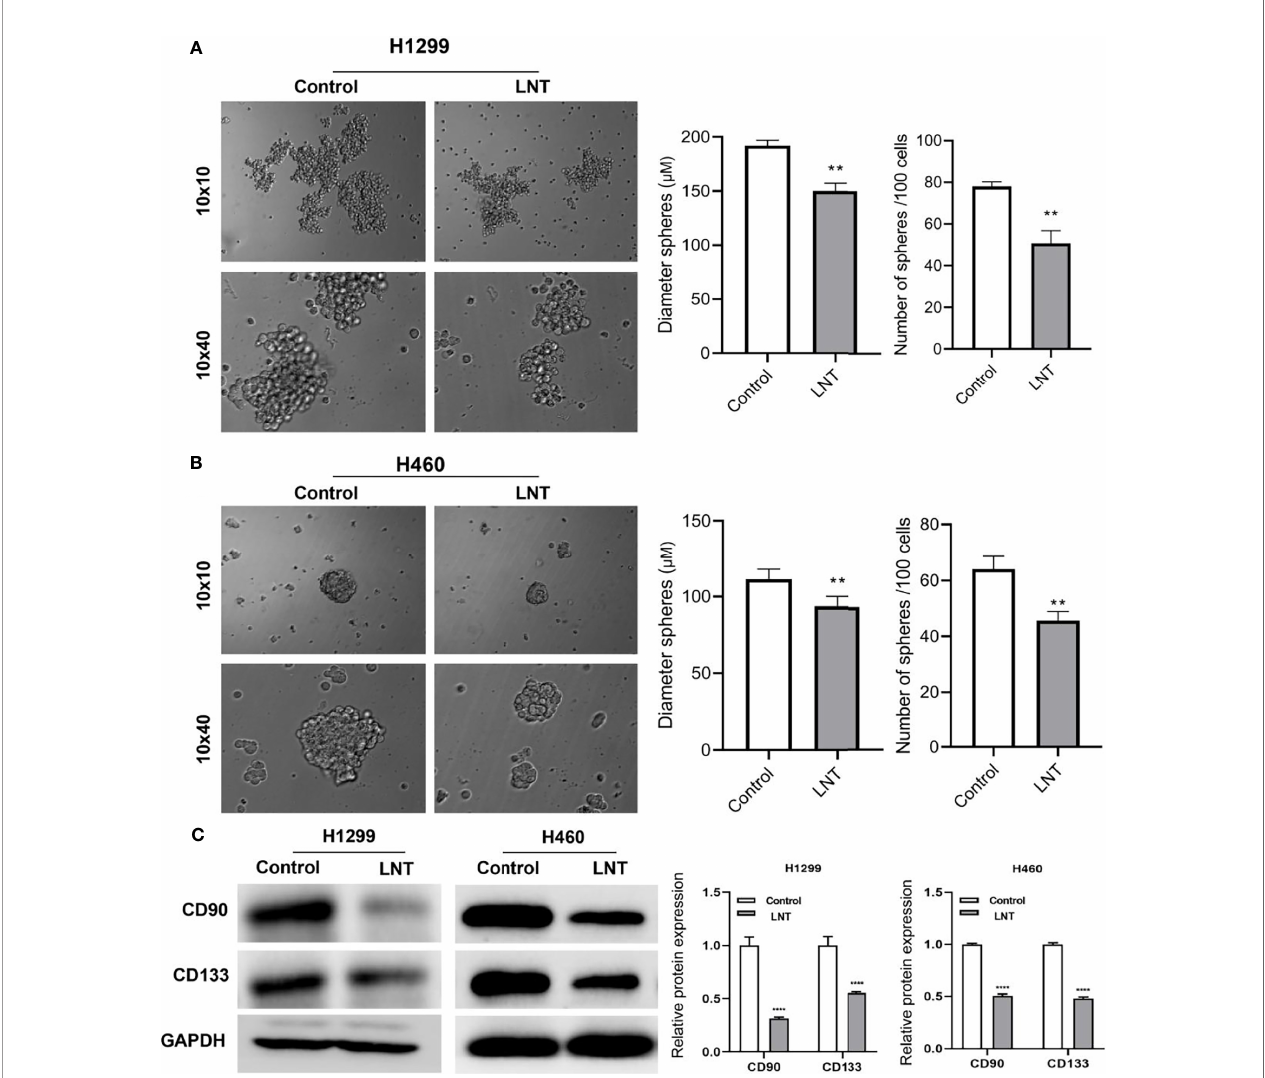
FIGURE 2 | LNT can inhibit the stemness of lung adenocarcinoma cells. After treatment of H1299 and H460 cells with 100 m M of LNT, (A) Stem cell sphere-forming assay to detect the sphere-forming ef fi ciency of H1299 cells; (B) Stem cell sphere-forming assay to detect the sphere-forming ef fi ciency of H460 cells; (C) Stem cell marker proteins CD90 and CD133 expression levels detected by Western blot. **P < 0.01 and ****P < 0.0001 vs . control